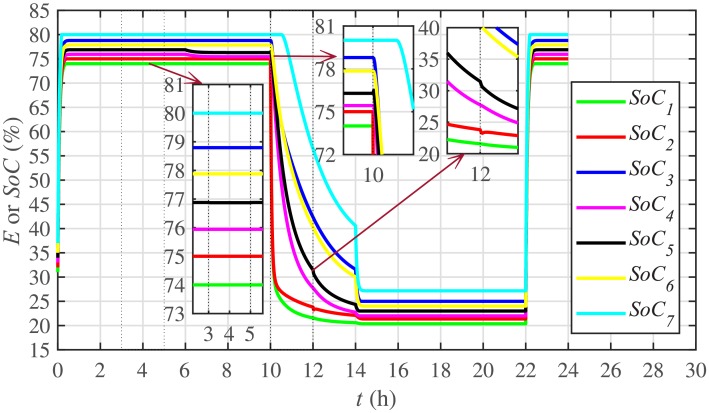
SoC tracking under case 6. [27].